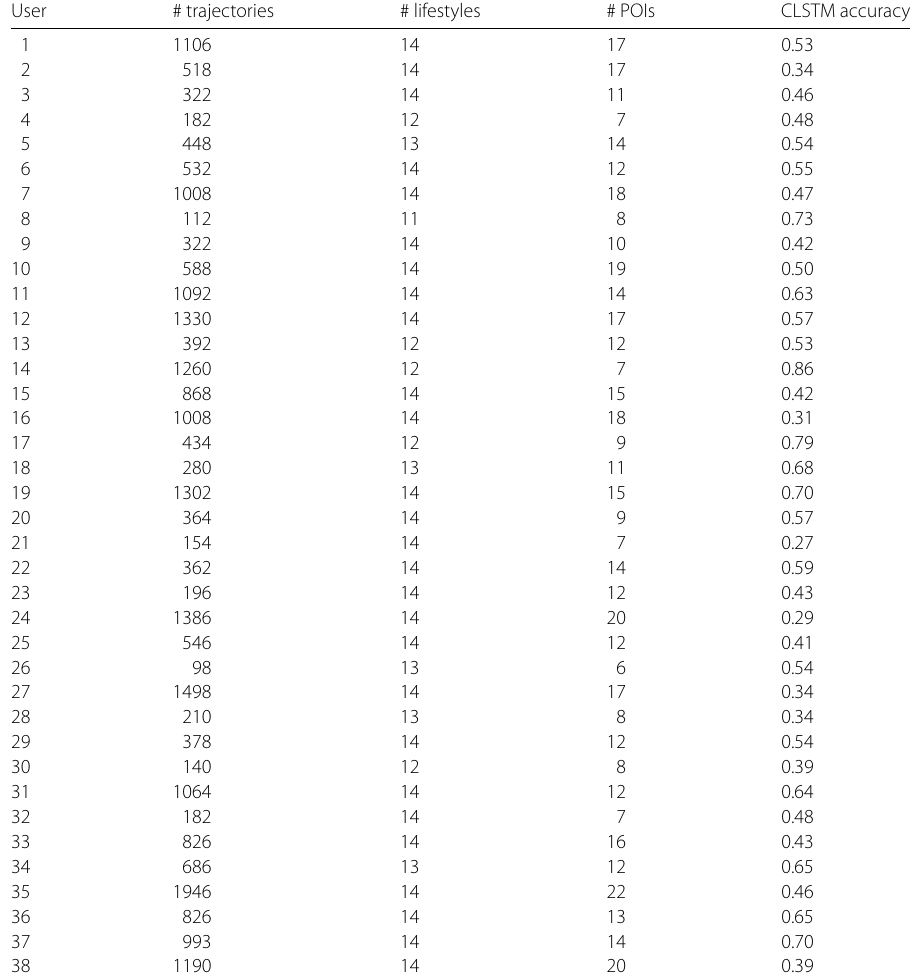
Table 8 Numbers of trajectories, lifestyles, and POIs as well as the CLSTM accuracy for each of the 38 users